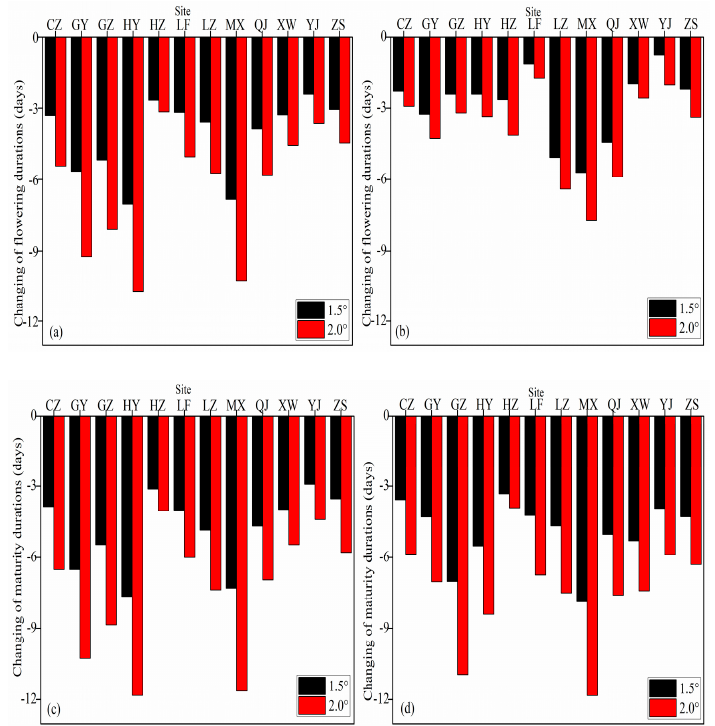
Figure 3. Changes in the flowering durations and maturity durations under the 1.5 and 2.0 °C warming scenarios relative to the baseline time for ( a , c ) early mature rice and ( b , d ) late mature rice. From Figure 3, it is indicated that the maturity durations of early mature rice would decrease 2.9